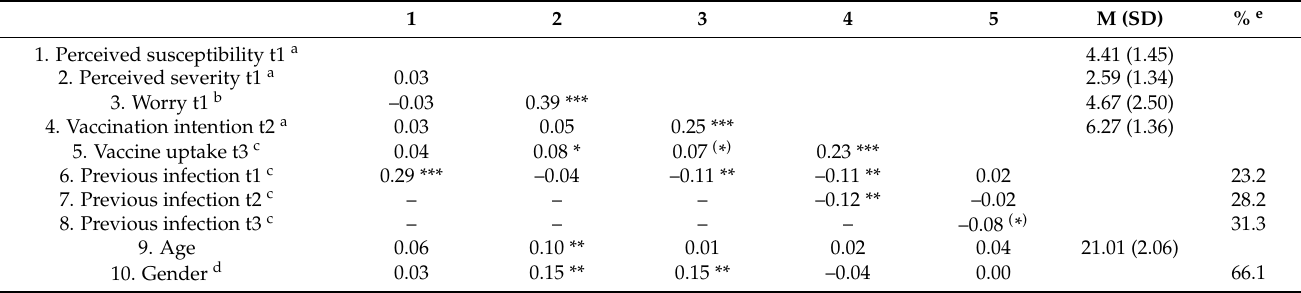
Table 1. Descriptives and Pearson correlations between study